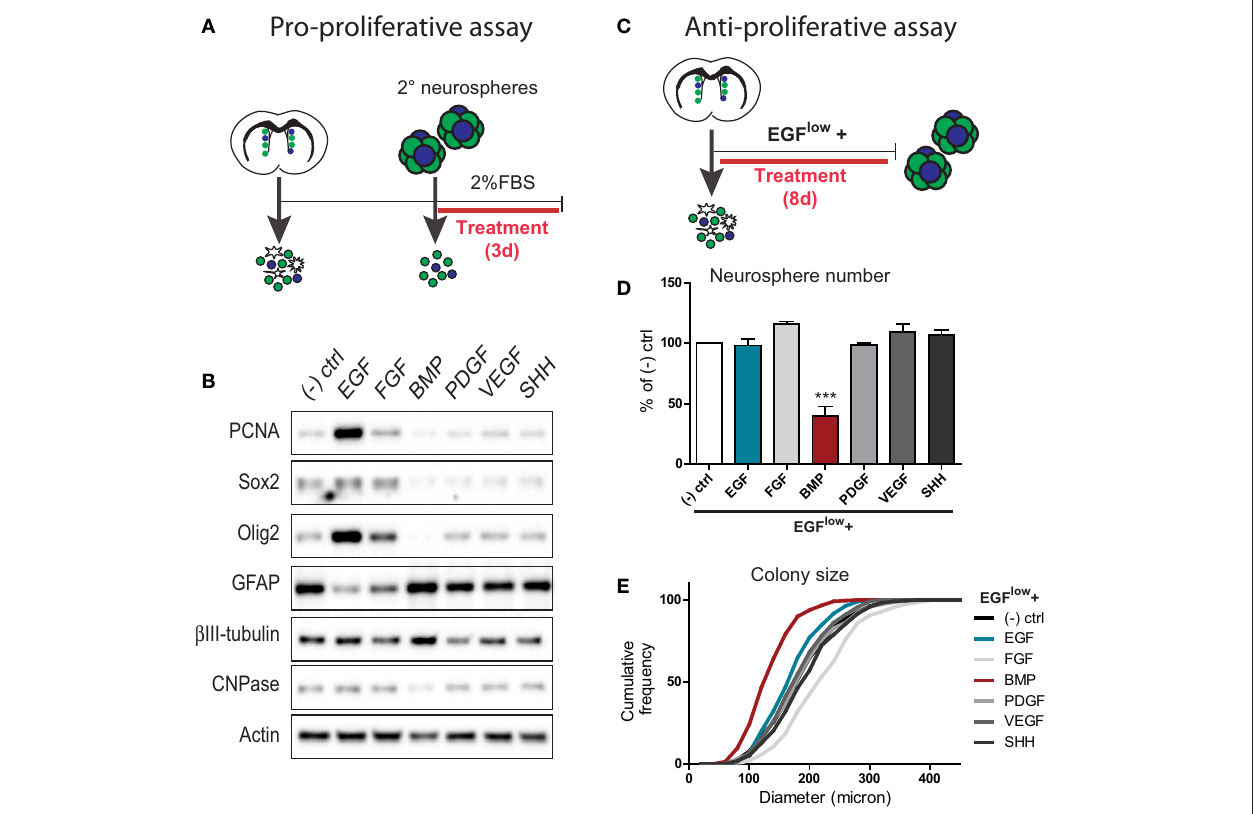
FIGURE 1 | Comparison of the pro- and anti- proliferative effects of 6 families of neurogenesis regulators on SVZ-derived neural precursor cultures. (A,B) Assay for pro-proliferative effects. Experimental paradigm (see Materials and Methods for details) (A) . Western blotting analysis of cell lysates following growth factor treatments (representative example from 1 of 3 experiments) (B) . Note that EGF is the prominent stimulator of markers of proliferation (PCNA) and TAPs (Sox2, Olig2). (C–E) Assay for anti-proliferative effects. Experimental paradigm (see Materials and Methods for details) (C) . Quantification of the effects of growth factor treatments on neurosphere numbers (D) and sizes (E) . Note that BMP exerts a powerful anti-proliferative effect on neural precursors during neurosphere formation. *** p < 0.001 , One-Way ANOVA (Dunnett’s post-hoc test). Data are represented as mean ±